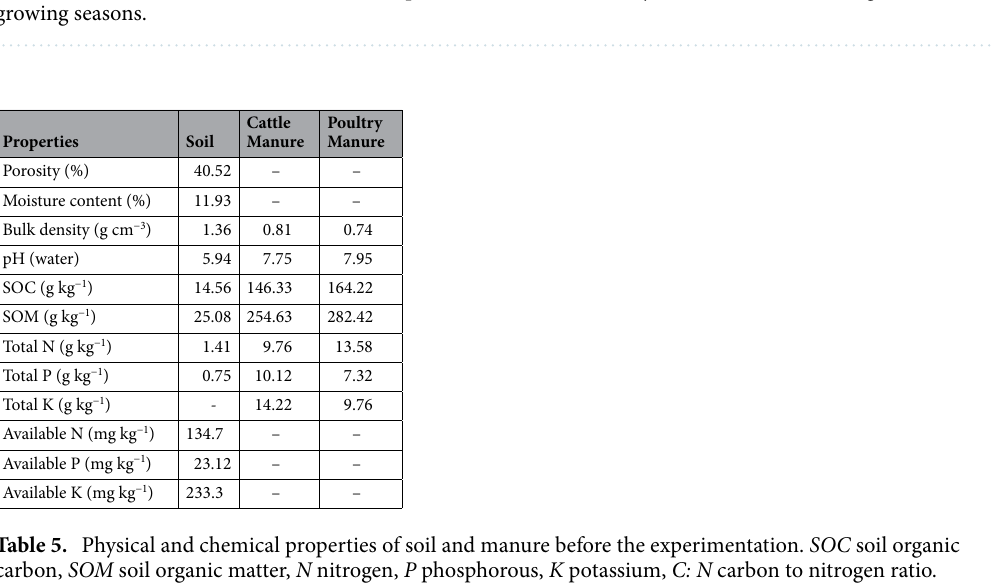
Table 4. Mean maximum and minimum temperatures, relative humidity, and total rainfall during both growing seasons.